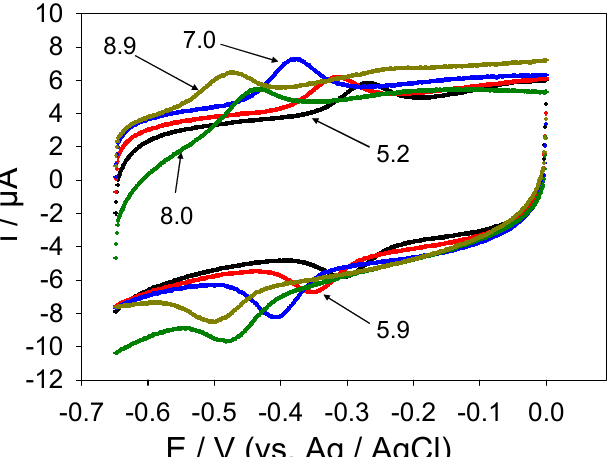
Figure 14. Voltammogams obtained using a SWCNT/GOx/Nafion-modified gold working electrode in buffers of various pH values. The scan rate employed in each case was 100 mVs -1